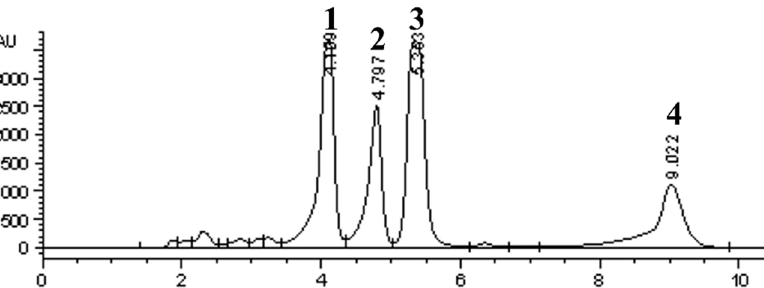
Figure 2. HPLC profile of the surface material of M. tanarius new fruit extract. Three experiments were carried out, and one representative result is shown. Peaks: 1: propolin D; 2: propolin F; 3: propolin C; 4: propolin G.